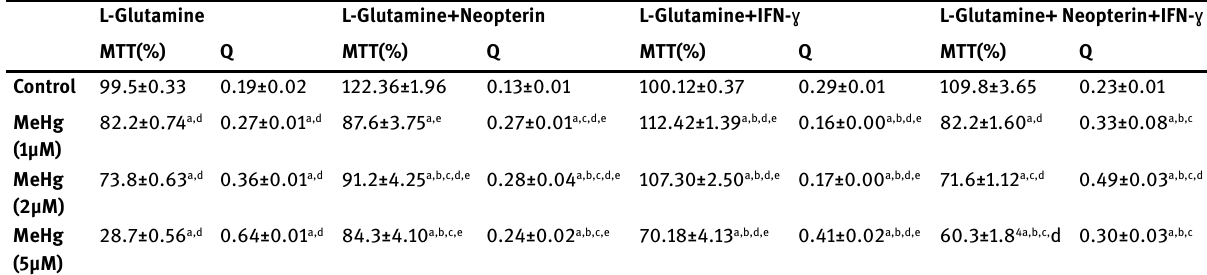
Tables 1: Total mitochondrial metabolic activity and oxidative stress coefficient of MeHg-exposed SH-SY5Y human neuroblastoma cell line at the end of the 24-hour period. ( IFN- ɣ : Interferon-gamma; MetHg: Methyl mecury; MTT: Cell viability; Q:[(NOx/Cc)/(MTT/Cc)], oxidative stress coefficient